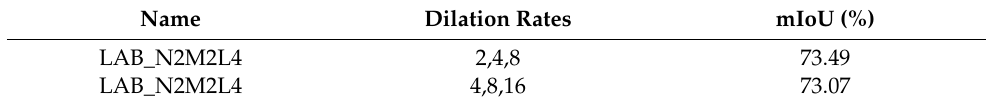
Table 3. Results of the LAB encoder with different combinations of dilation rates.